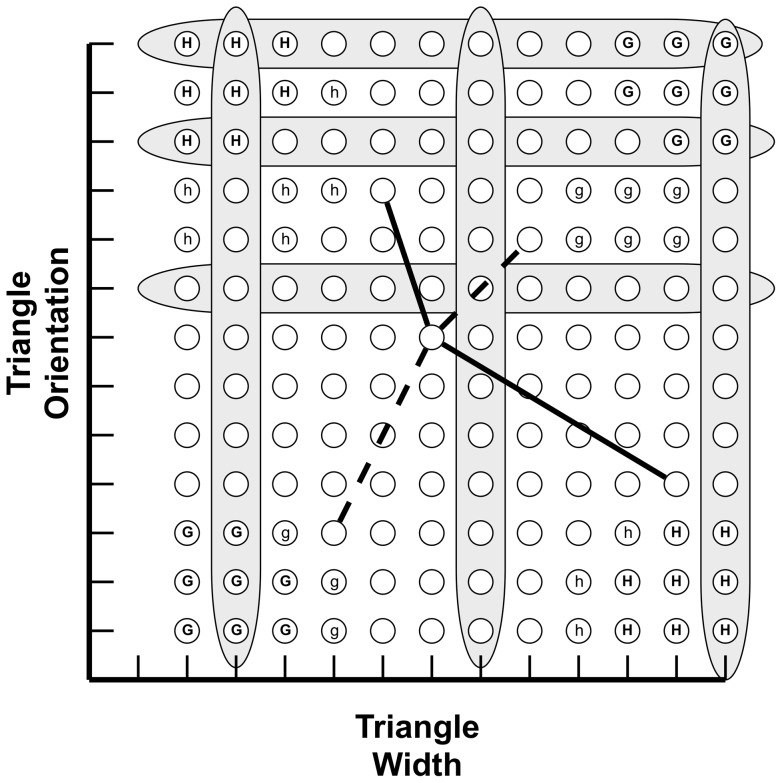
Analysis of the category structure in Experiment 2.The logic is identical to that of the matrix in Figure 2.